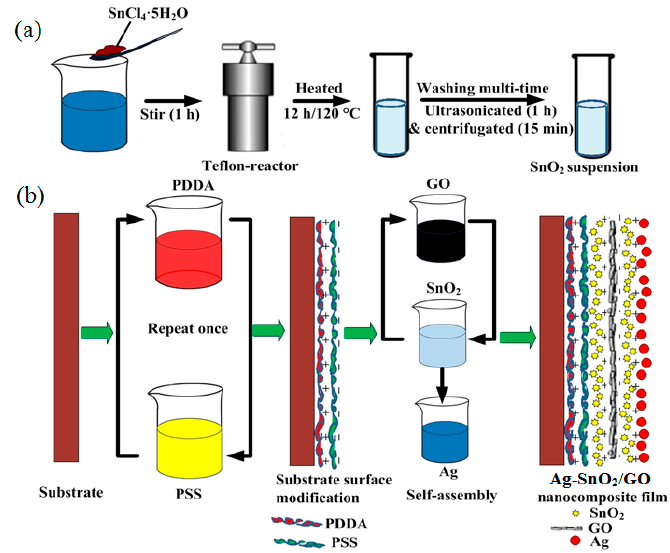
Figure 1. ( a ) Hydrothermal synthesis of SnO 2 and ( b ) layer-by-layer self-assembly of the Ag–SnO 2 /GO nanocomposite